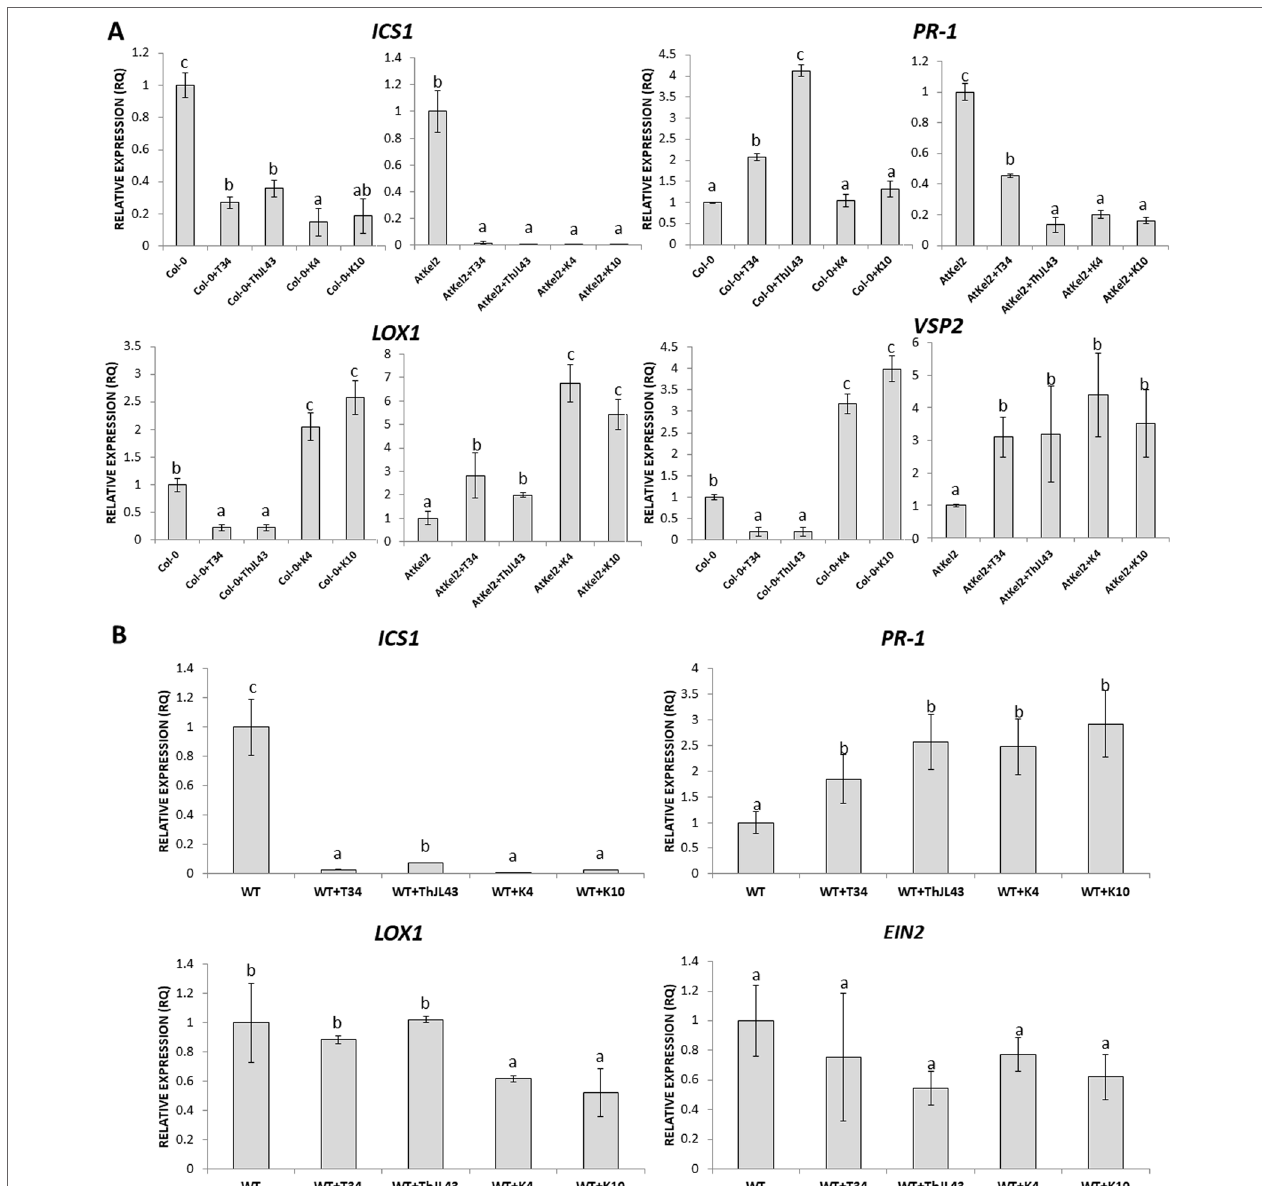
FIgURE 6 | Quantitative reverse transcription polymerase chain reaction (RT-qPCR) analysis of the expression of some defense genes in the roots of A. thaliana wild type (Col-0) and transgenic line (AtKel2) plants (a) and in tomato WT roots (B) inoculated with the T. harzianum strains T34 (control), ThJL43 (transformation control), K4 or K10 ( Thkel1 gene silenced transformants). Genes of the isochorismate synthase 1 ( ICS1 ), pathogenesis-related protein 1 ( PR-1 ), lipoxygenase 1 ( LOX1 ), vegetative storage protein ( VSP2 ), and ethylene signaling protein ( EIN2 ). Values correspond to relative measurements against plants without infection (2 –ΔΔCt = 1). The Arabidopsis actin gene and the tomato actin gene were used as an internal reference gene. Data are the mean of three biological replicates for each condition with the corresponding standard deviation, and for each biological replicate and condition, roots from five plants were used. One-way analysis of variance (ANOVA) was performed, followed by the Tukey’s test. Different letters represent significant differences ( P < 0.05) between plants with and without fungal